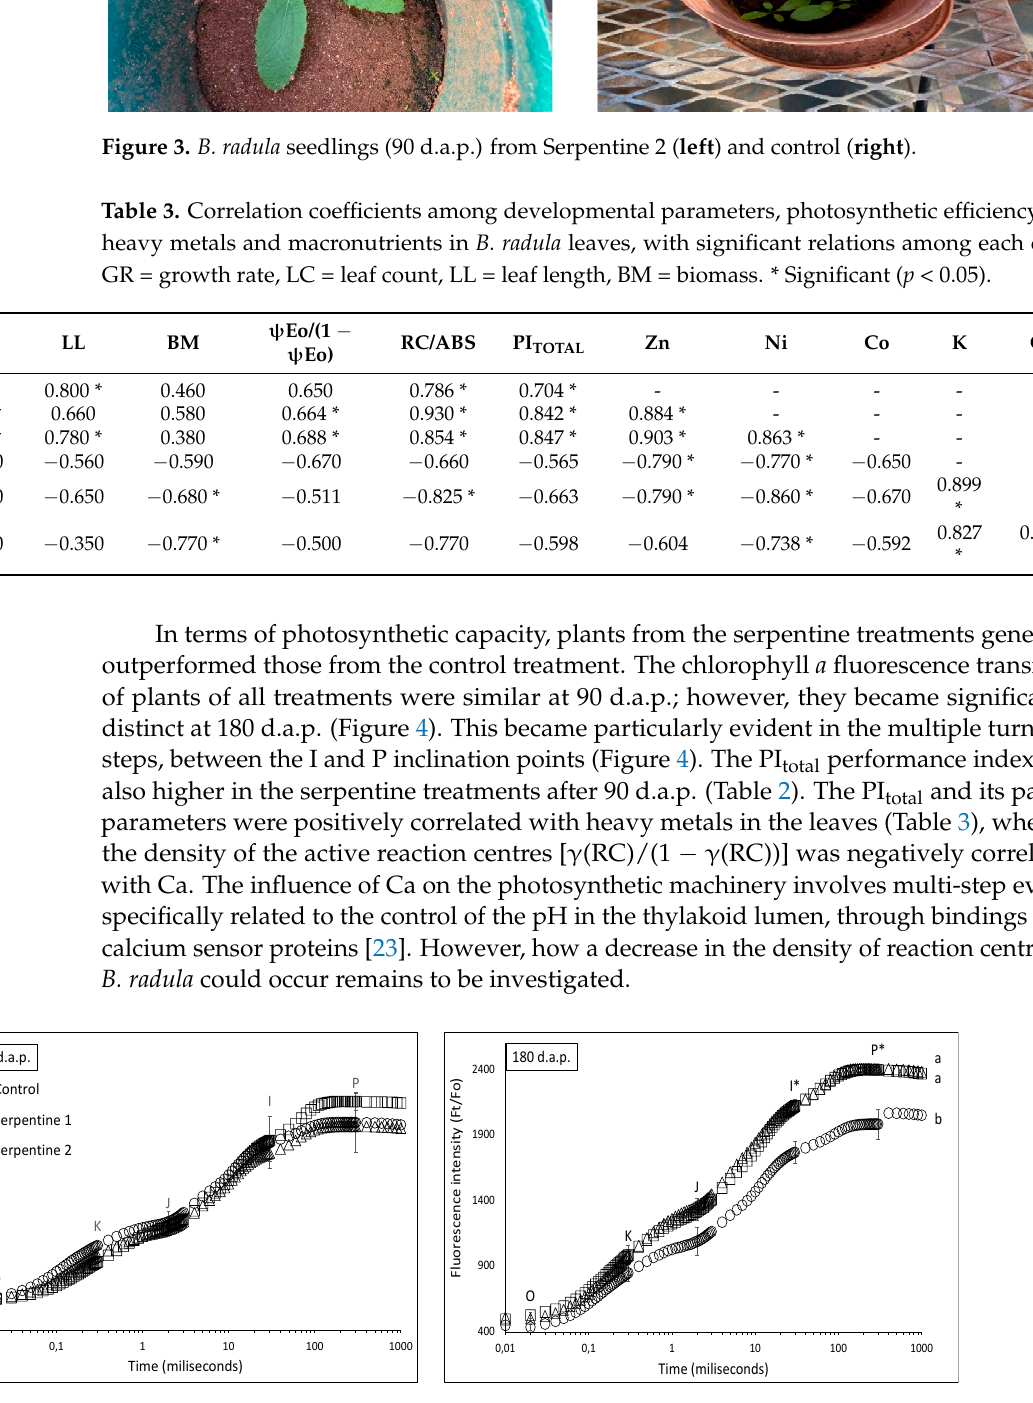
Figure 4. Chlorophyll a fluorescence transients (mean ± std) of B. radula leaves for the study treatments. Different lowercase letters indicate significant difference among treatment curves. * significantly different turnover steps among treatments (Tukey; p < 0.05). Table 3. Correlation coefficients among developmental parameters, photosynthetic efficiency and heavy metals and macronutrients in B. radula leaves, with significant relations among each other.